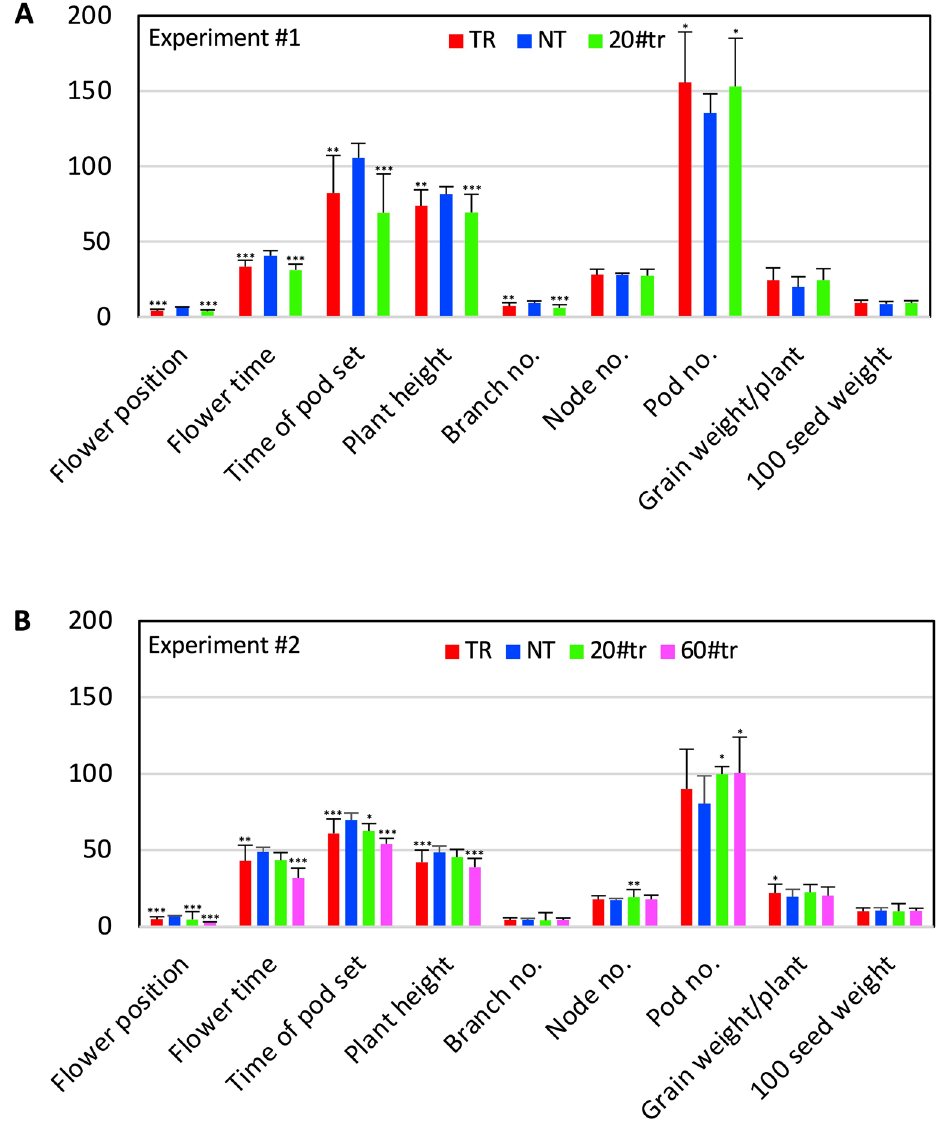
Figure 4. Phenotypic changes in T 1 transgenic (TR) soybean plants expressing the ZmSOC1 in the two experiments, where the seeds were sowed on May 4th in the experiment #1 and June 4th in the experiment #2, respectively. #20tr and #60tr are two independent TR lines. Y-axis showed mean value and STDEV of 16 nontransgenic (NT), 52 TR, and 16 #20tr plants in the experiment #1 ( A ) and 32 NT, 44 TR, 11 #20tr, and 7 #60tr lines in the experiment #2 ( B ). Flower position: The node number where the first flower appeared. Flowering time: Days when the first flowered appeared after the seeds were sowed. Time of pod set: Days when the first pod was set after the seeds were sowed. Plant height (cm): The height of the mature plant. Branch no., Node no., and Pod no.: The numbers for each mature plant were counted. Grain weight/plant (g): Weight of dry seed. 100 seed weight (g): 100 seed weight for each plant. For each of the nine traits, statistical analysis was conducted between NT and TR (or any of the individual TR line) separately. Significance codes: *** P < 0.001, ** P < 0.01, * P <